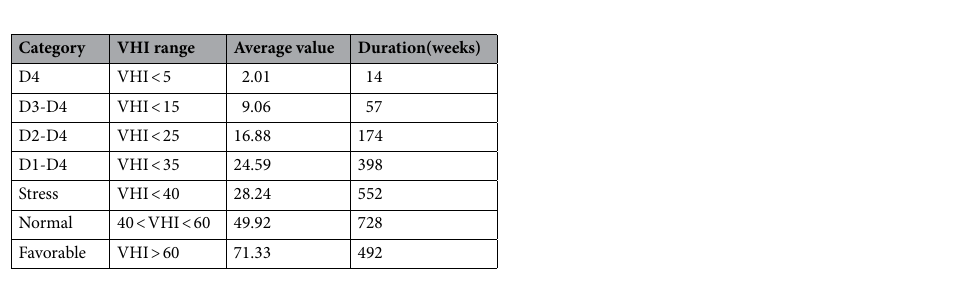
Table 3. Regional average value and their corresponding duration of weekly VHI at different ranges for the period of 1982–2016 in Jing-Jin-Ji region.